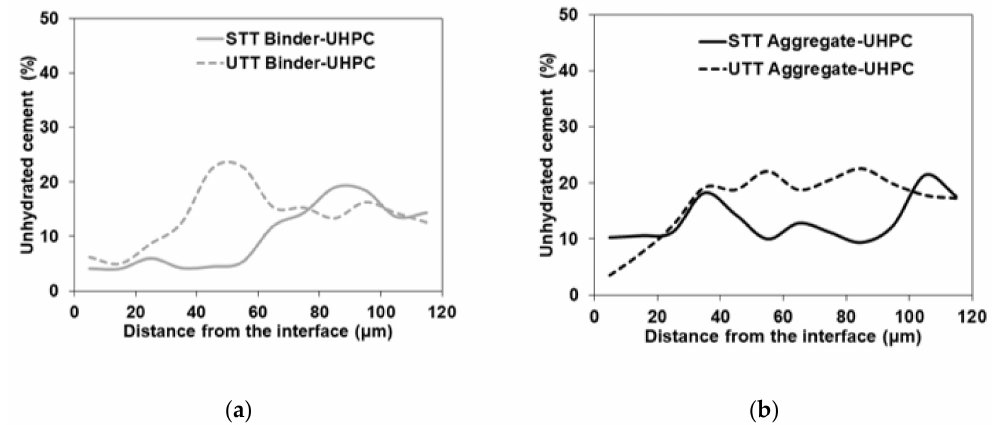
Figure 16. Fraction of unhydrated cement away from binder-UHPC and aggregate-UHPC interface for ( a ) shuttering plywood (STT); ( b ) untreated plywood (UTT)